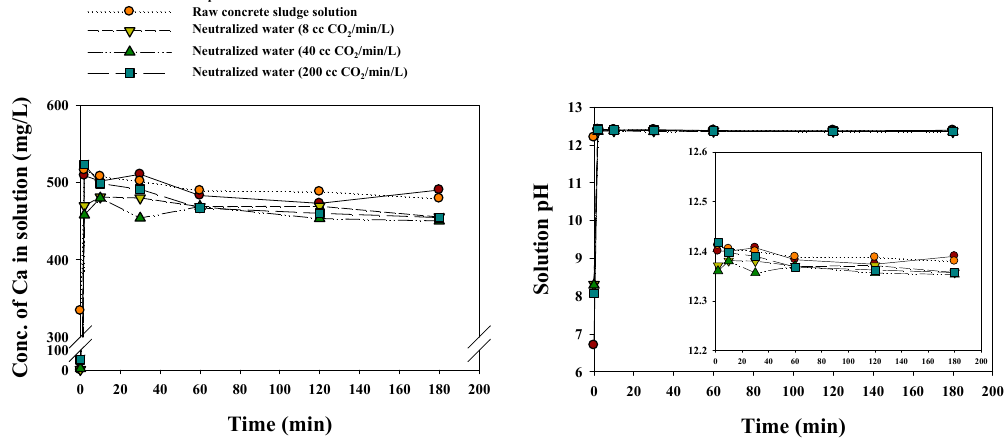
Figure 10. Changes in Ca concentration and solution pH from raw concrete powder dissolution using tap water, raw concrete sludge solution and neutralized water by carbon mineralization (8, 40 and 200 cc CO 2 /min/L).